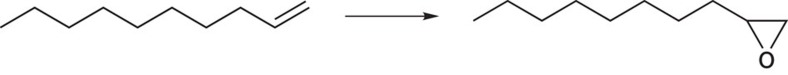
Epoxidation of a terminal linear alkene.(48 h, dec-1-ene 10 ml, 90 °C, GO 0.1 g). The epoxidation of a terminal linear alkene such as dec-1-ene usually requires the use of stoichiometric oxidants, supported metal catalysts and/or radical initiators.